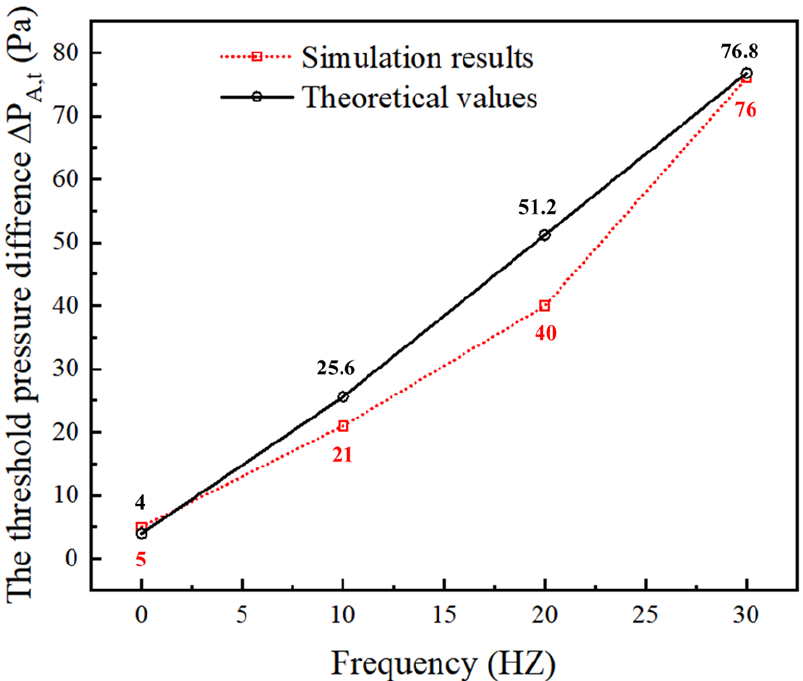
Figure 3. The threshold pressure difference ∆ P A , t required for the elastic wave to successfully squeeze droplets under different frequencies: comparisons between the simulation results and theoretical predictions by Deng et al. [41].